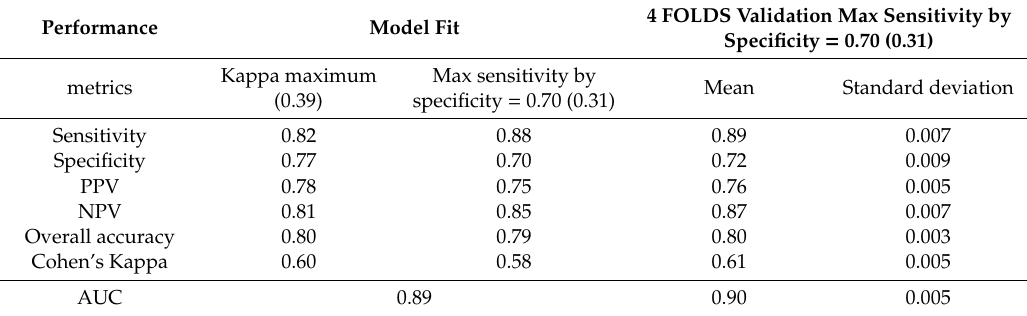
Table 5. Model fit and predictive performance of the “deadwood-uncertainty” model measured by sensitivity, specificity, positive prediction value (PPV), negative prediction value (NPV), overall accuracy, and Cohen´s Kappa for thresholds based on Kappa maximum (0.39) and the maximum sensitivity by the specificity of 0.70 (0.31). In addition, threshold-independent area under the ROC-curve (AUC) was provided for di ff erent classes’ separation. Independent validation was performed on four independent validation datasets with their results calculated for the selected threshold of maximum sensitivity by specificity of 0.70 (0.31). The validation results are presented below for comparison with arithmetic mean and standard error values showing the amount of variation between the results of di ff erent folds.